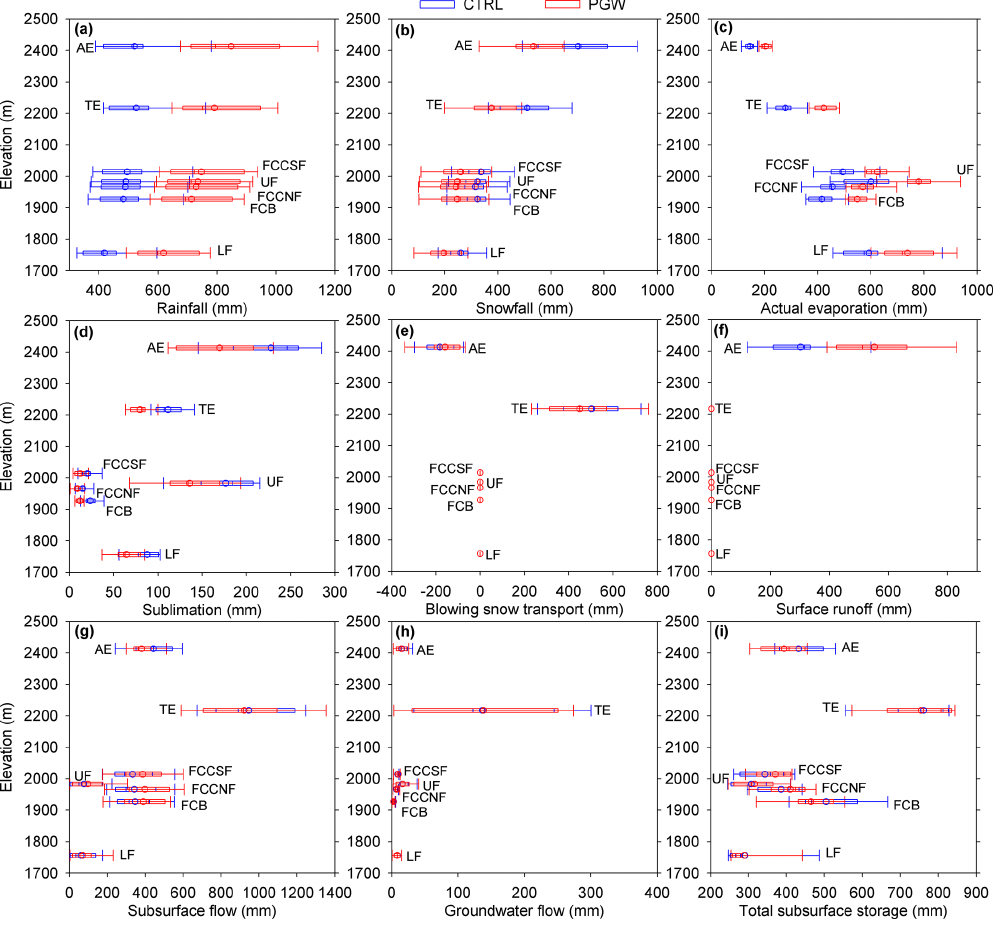
Figure 7. Boxplots of the simulated annual water balance variables for WRF CTRL and PGW for the alpine (AE), treeline (TE), upper forest (UF), forest clearing blocks (FCB), forest circular clearing north-facing (FCCNF), forest circular clearing south-facing (FCCSF), and lower forest (LF) ecozones. (a) Rainfall, (b) snowfall, (c) actual evaporation, (d) sublimation, (e) blowing snow transport, (f) surface runoff, (g) subsurface flow, (h) groundwater flow, and (i) storage change. The vertical line within the box is the median value of the 8 water year data, the box is the interquartile range ( Q 1 : 25% to Q 3 : 75%) of the 8 water year data, the whiskers are the minimum and maximum, and the circle is the mean value of the 8 water year